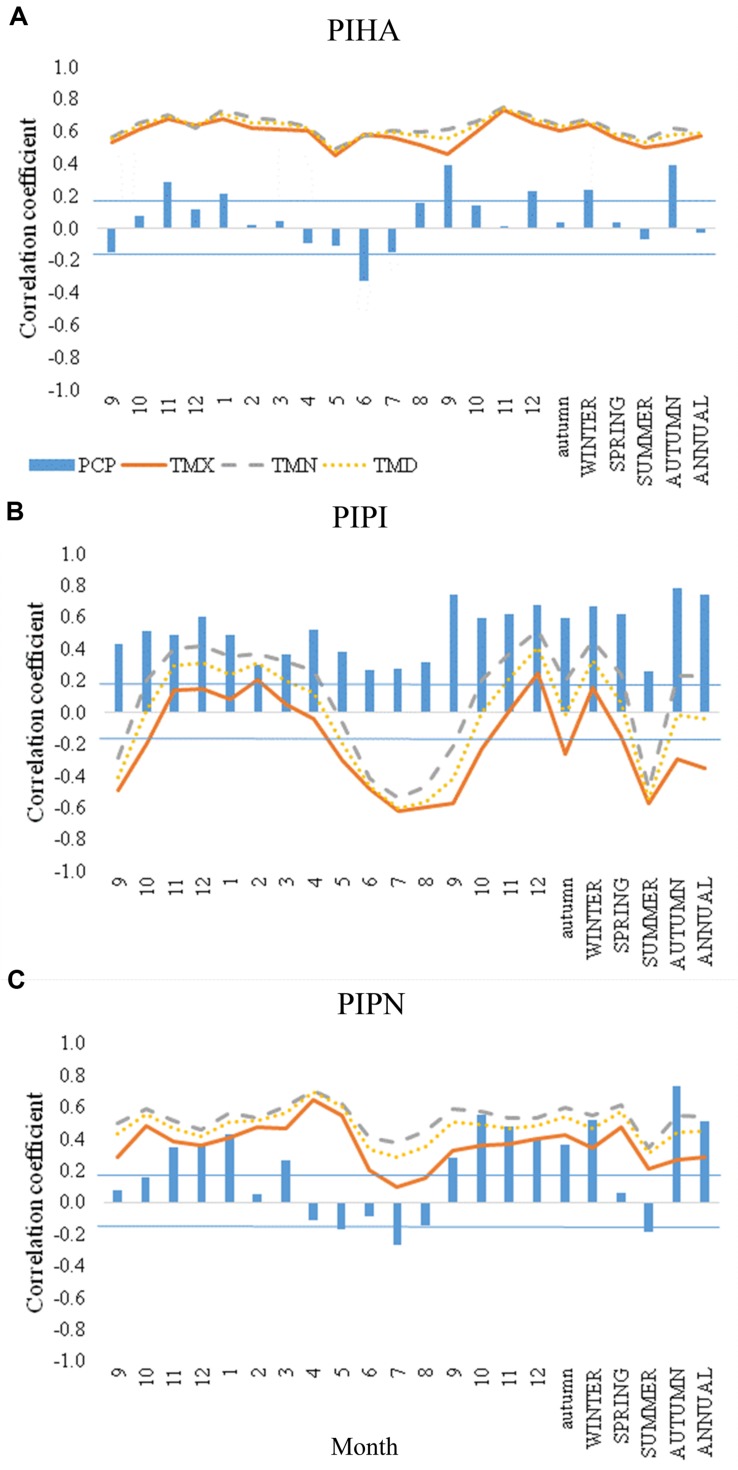
Correlation coefficient values between IADF frequency, total precipitation (PCP) and maximum (TMX), minimum (TMN), and mean (TMD) monthly temperature for the three species [(A) Pinus halepensis (PIHA), (B) Pinus pinaster (PIPI), and (C) Pinus pinea (PIPN)]. IADF frequency is correlated with climate data at monthly and seasonal scale from September of previous year to December of the current year, and at annual scale. First numbers from 9 to 12 to the left of the graphs and lowercase letters refer to the previous year. Blue horizontal lines indicate the limits of the correlation coefficient (±0.196) for significance at p < 0.05 (n > 100).